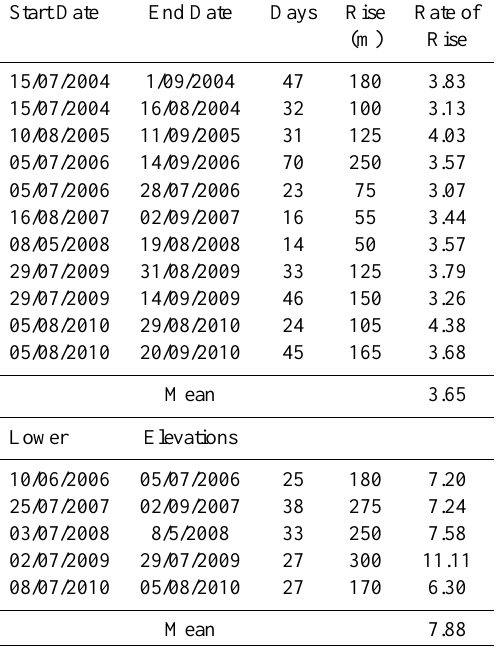
Table 2. Periods between TSL observations separated by at least 14 days. For each period the rate of rise is determined. The group of observations for lower elevations is for periods where the TSL on the start date was below 750m.